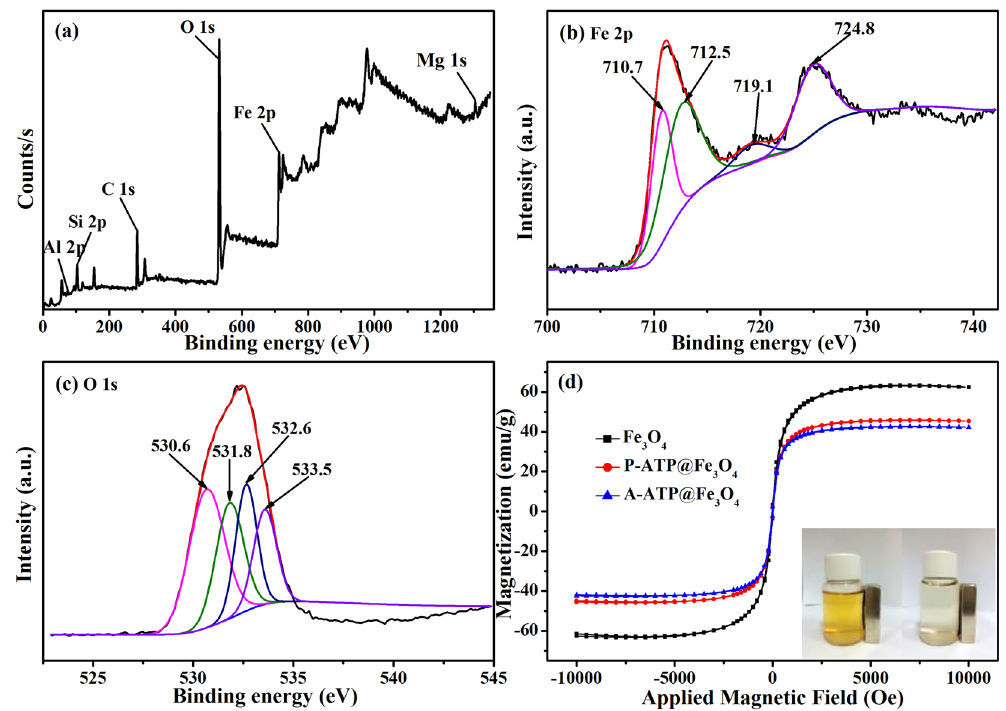
Figure 3. ( a ) XPS spectra of A-ATP@Fe 3 O 4 , high-resolution XPS spectra of ( b ) Fe2p, ( c )O1s. ( d ) Magnetization curves of P-ATP@Fe 3 O 4 and A-ATP@Fe 3 O 4 nanocomposites and Fe 3 O 4 serves as control. The inset pattern is a photograph of the magnetic separation, which shows that the nanoparticles can be separated easily with a